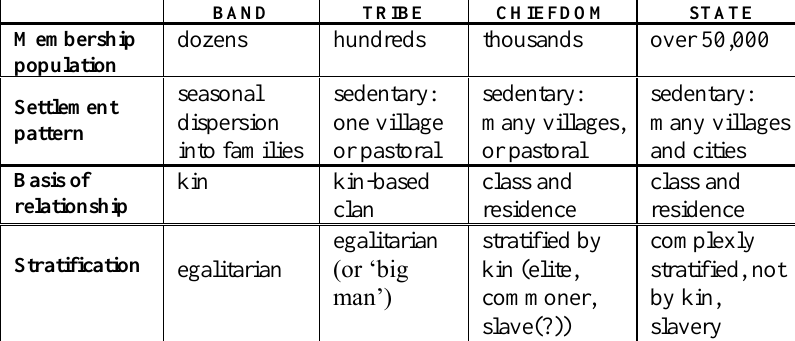
Table I. Types of Social